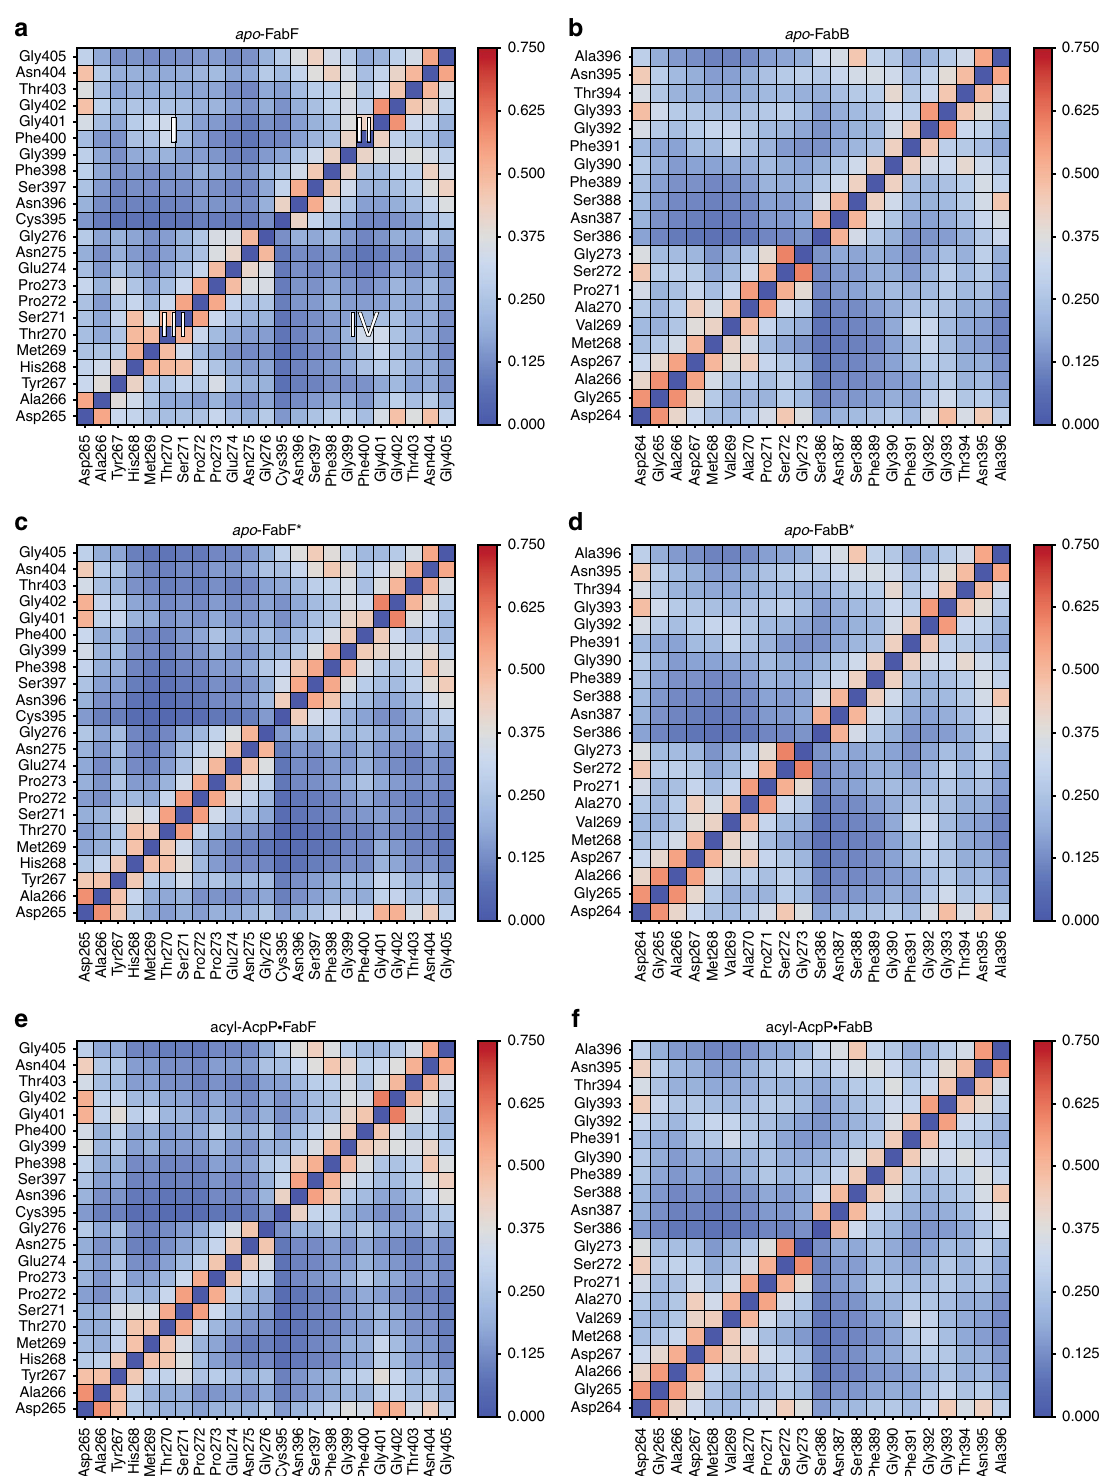
Fig. 8 Average cross correlations of the motions of key loop 1 and 2 residues sampled computationally. Cross correlations were determined by computing a motion vector for each residue of loop 1 and loop 2 from its prior position to its current over the course of each simulation. In this manner, motion vectors for each pair of residues of loop 1 and 2 are calculated for each frame of simulation data. Heat maps generated from the cross-correlation analysis of the motions of loop 1 and 2 residues of a apo -FabF, b apo -FabB, c apo -FabF*, d apo -FabB*, e acyl-AcpP·FabF, and f acyl-AcpP·FabB, respectively, sampled using molecular dynamics (MD) simulations. a The heat map has been divided into four quadrants; quadrants II and III illustrates cross correlations of the motions of residues within loops 1 and 2, respectively. Inter-loop cross correlations are shown in quadrants I and IV. Note that each heatmap is symmetric about the diagonal that bisects quadrants II and